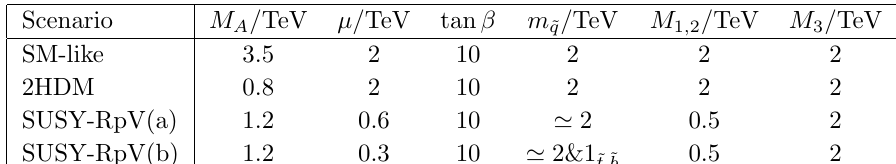
Input parameters for various scenarios under consideration. With 2&1